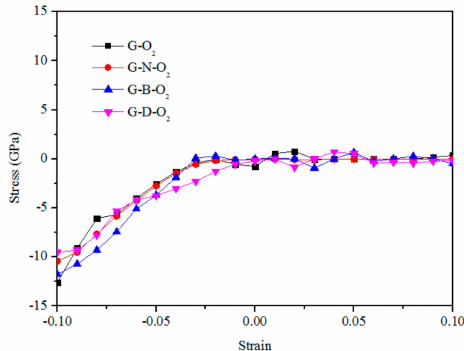
Figure 3. Stress as a function of equibiaxial strain for G–O 2 , G–N–O 2 , G–B–O 2 , and G–D–O 2 .